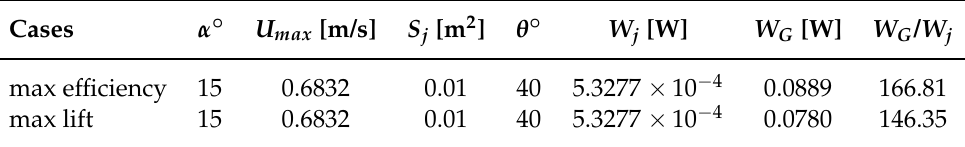
Table 4. Power ratio values characterizing the maximum efficiency and maximum lift